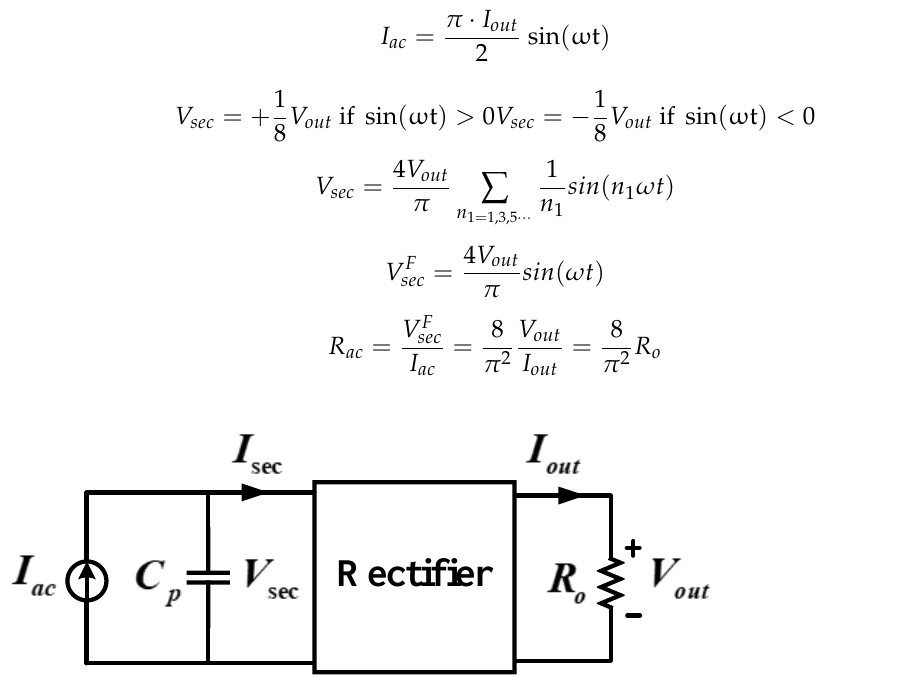
Figure 4. Circuit diagram to derive the equivalent load resistance. In high-voltage applications, the secondary side of the transformer has a higher turn ratio than the primary side. If the turn ratio is equalized to the primary side, the equivalent load resistance can be expressed by Equation (11). Therefore, the equivalent resistance equation can be derived, and the voltage gain of the converter can be obtained through the Equations (5) and (9). When the secondary side voltage V sec is equalized to the primary side, we obtain the voltage gain Equation (12). When the primary side and secondary side voltages are calculated, the voltage gain can be expressed as Equation (13).